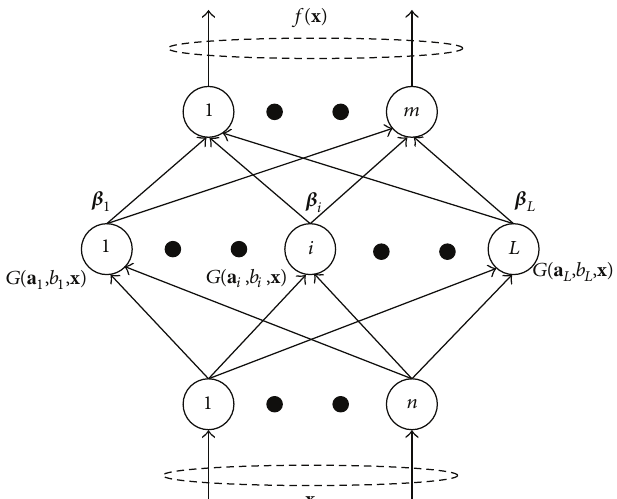
Figure 1: Single-hidden-layer feedforward